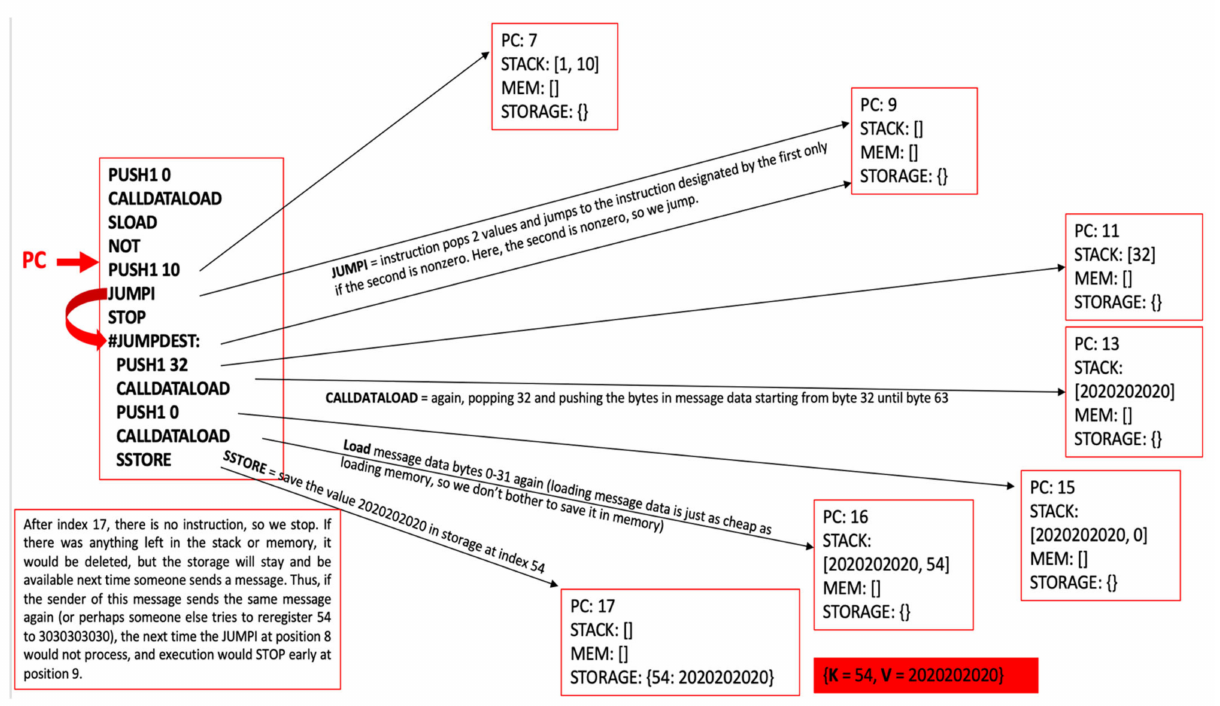
Figure 14. Ethereum Virtual Machine execution of the smart contract bytecode simple—sequence 2 (PC = Program Counter, MEM =